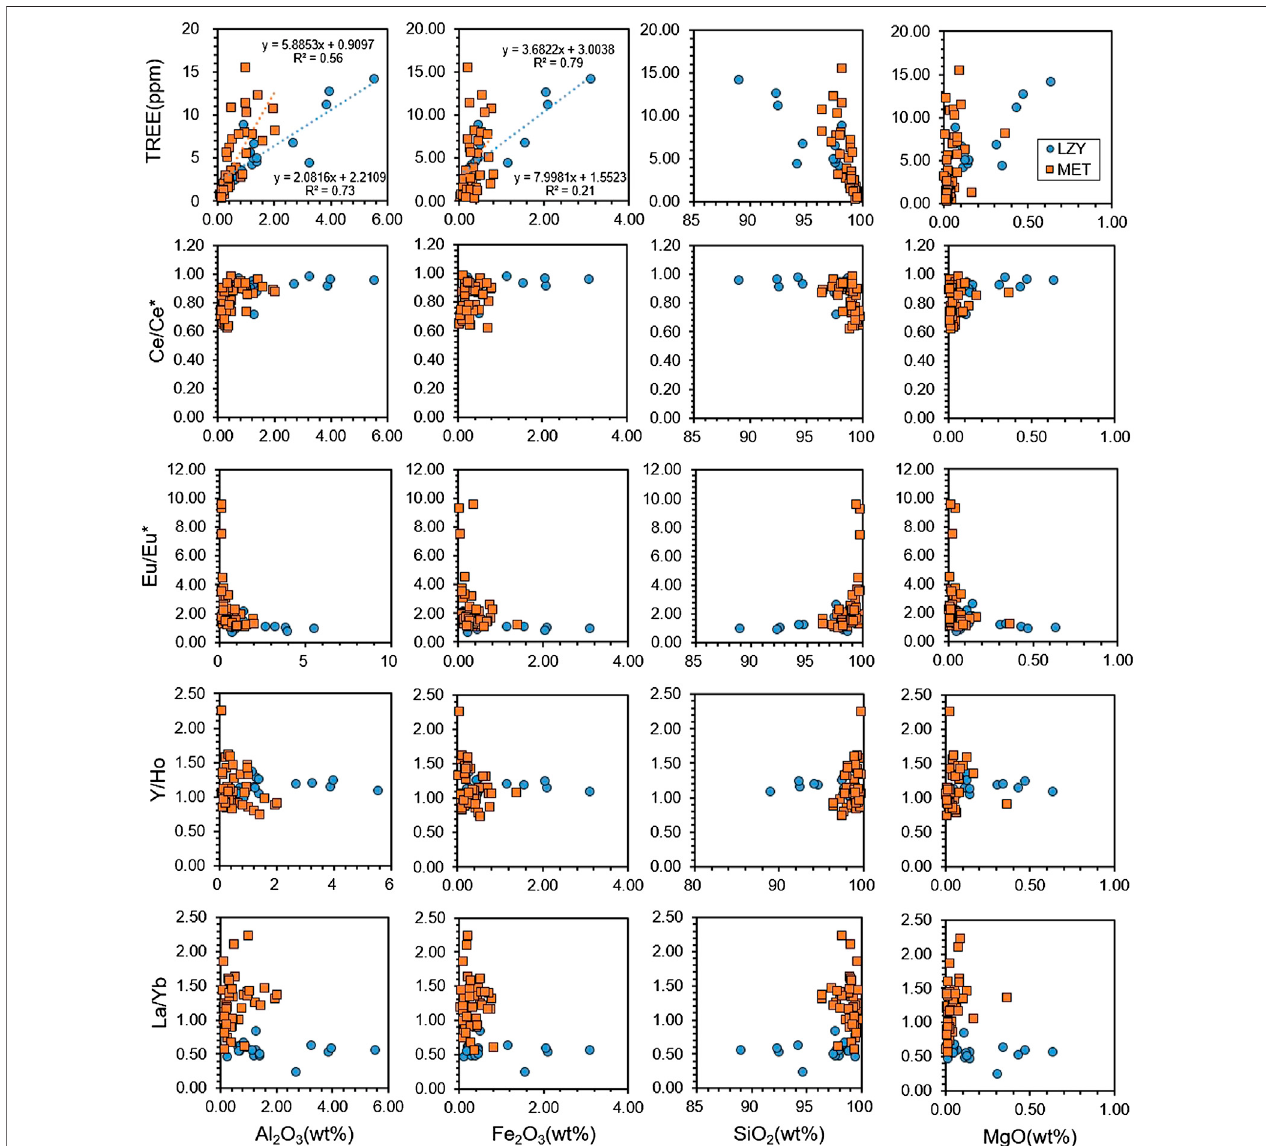
FIGURE 6 | Cross plots showing the correlations between major element contents (measured as oxides in wt%) and TREE (ppm), Ce/Ce*, Eu/Eu*, Y/Ho, and La/Yb.